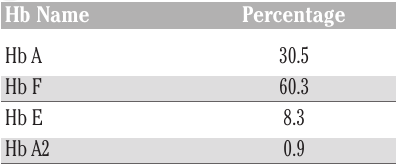
Table 1. Capillary-electrophoresis findings.